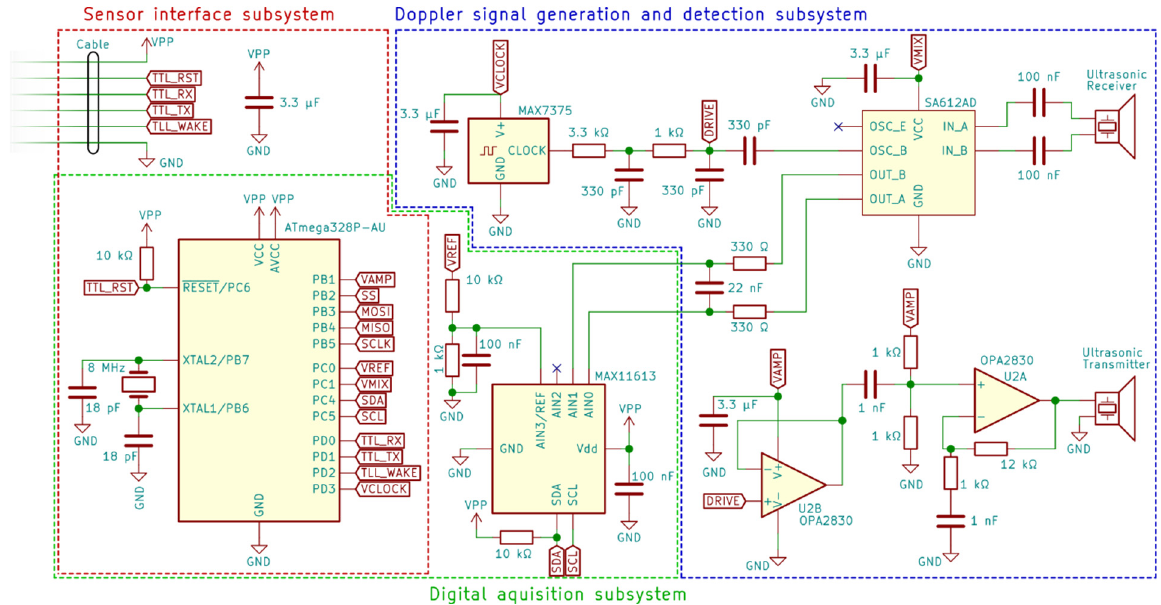
Figure 3. Circuit diagram of sensor. Components corresponding to each subsystem are contained within the dashed line coloured: blue, Doppler signal generation and detection subsystem (Section 2.1.1); green, digital signal acquisition subsystem (Section 2.1.2); and red, sensor interface subsystem